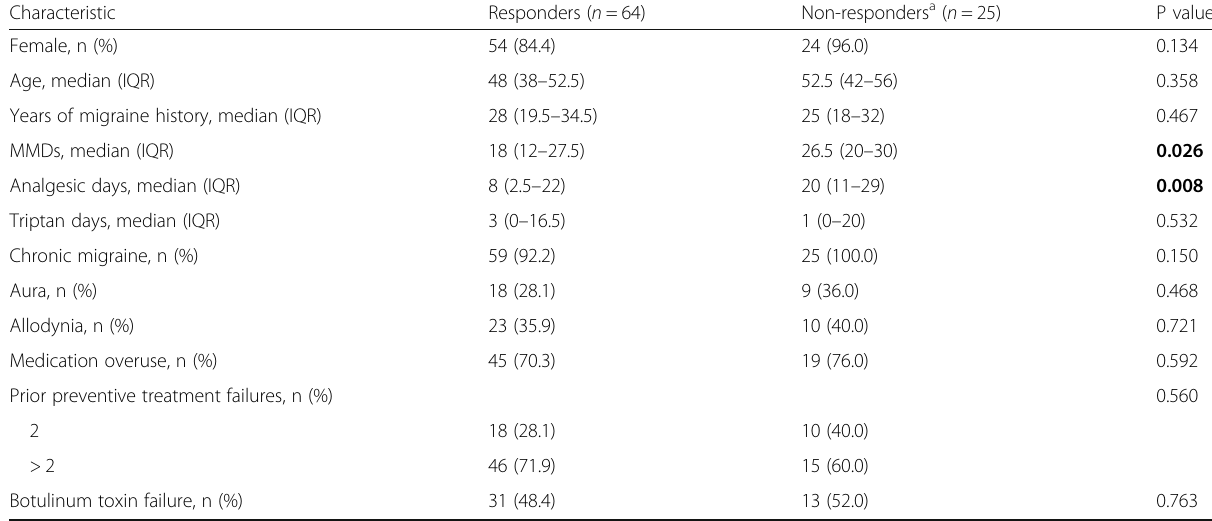
Table 3 Comparison of the baseline characteristics of responders within the first three months of erenumab treatment versus non-